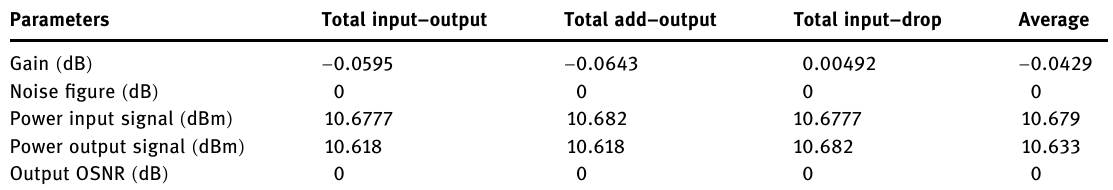
Table 2: The ratio of the total parameter related to the input, output, add, and drop calculated by dual - port WDM analyzer Parameters